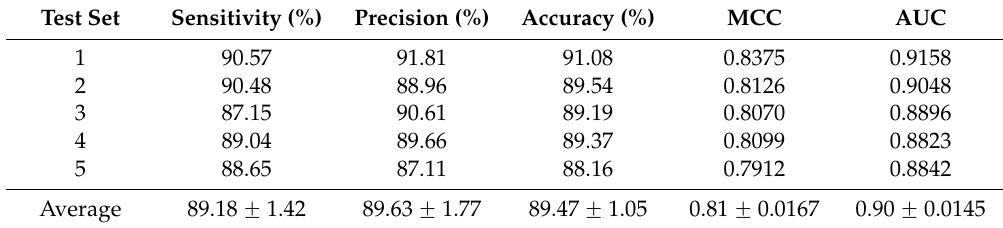
Table 1. The prediction results of the H. pylori dataset using the proposed method. Test Set